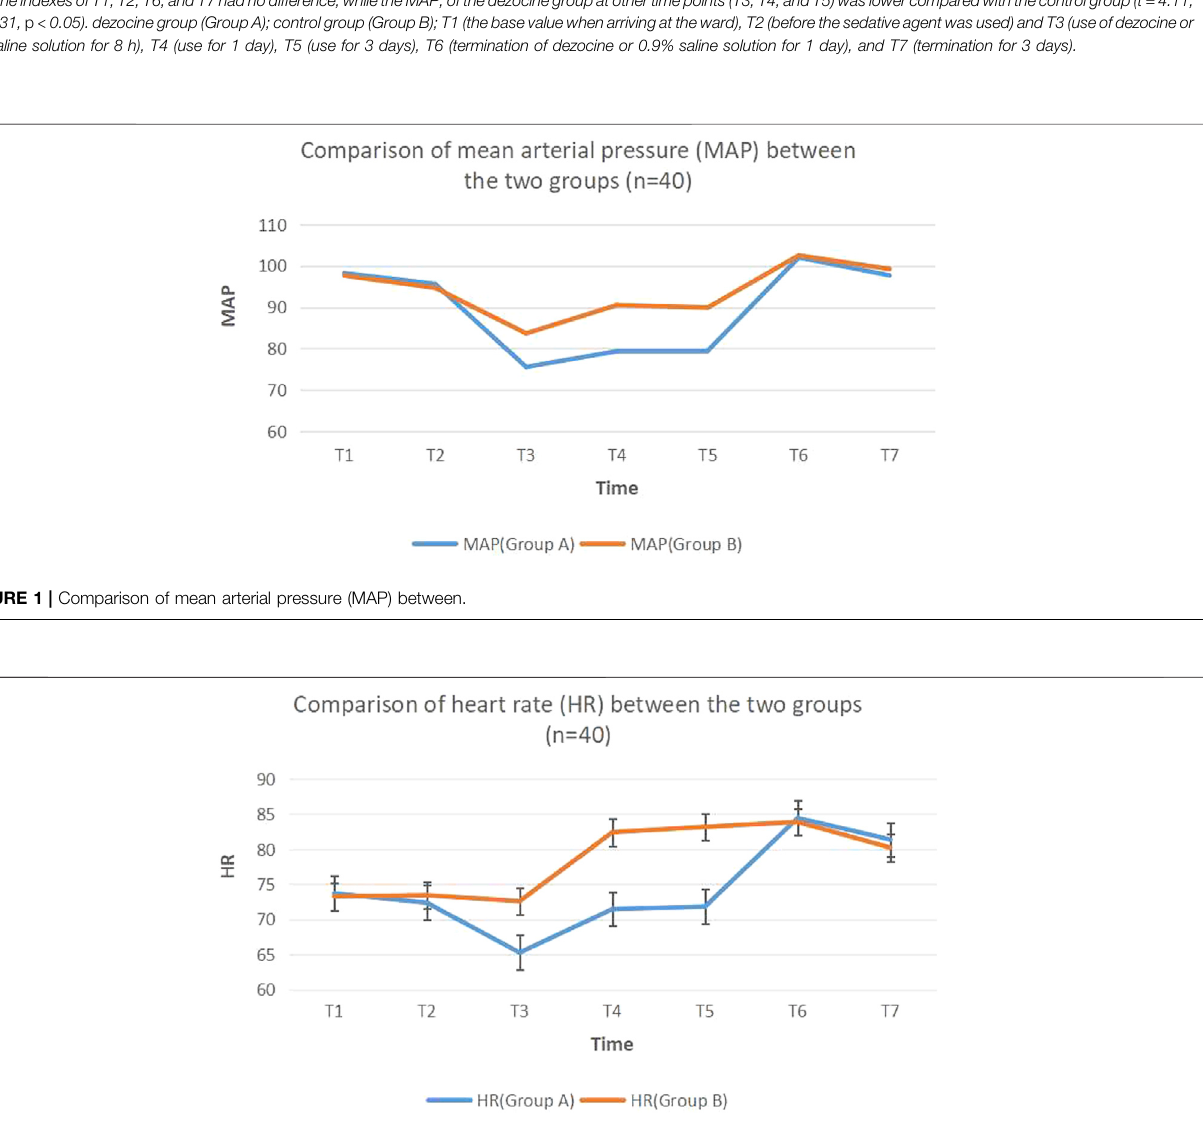
FIGURE 2 | Comparison of heart rate (HR) between the two